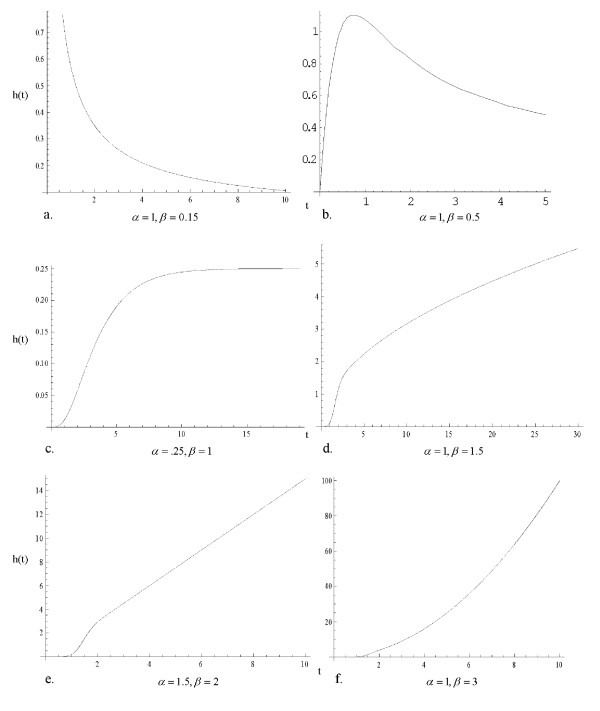
a) Hypertabastic hazard curve for 0 <β ≤ 0.25; b) Hypertabastic hazard curve for 0.25 <β < 1; c) Hypertabastic hazard curve for β = 1; d) Hypertabastic hazard curve for 1 ≤ β < 2; e) Hypertabastic hazard curve for β = 2; f) Hypertabastic hazard curve for β > 2.